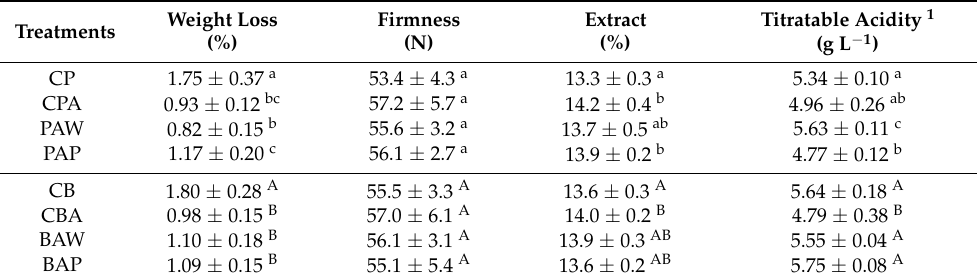
Table 3. The quality parameters of the apples uncoated and coated with alginate biofilms after 28 days storage at 2 ◦